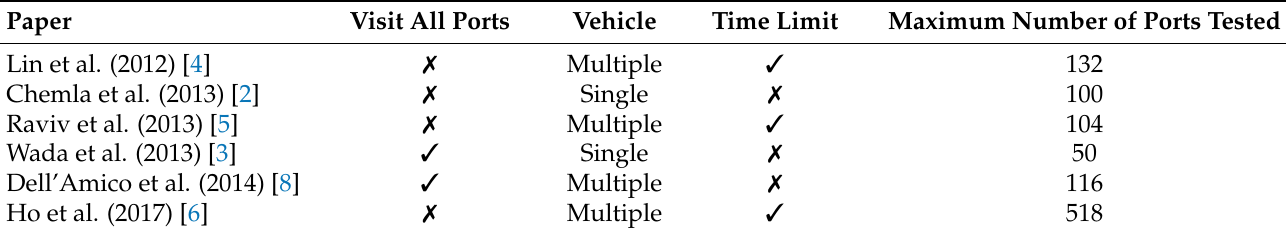
Table 1. Summary of the characteristics of the related literature. (cid:51) indicates that the proposed solution considers visiting all ports or a time limit. (cid:55) indicates that these are not